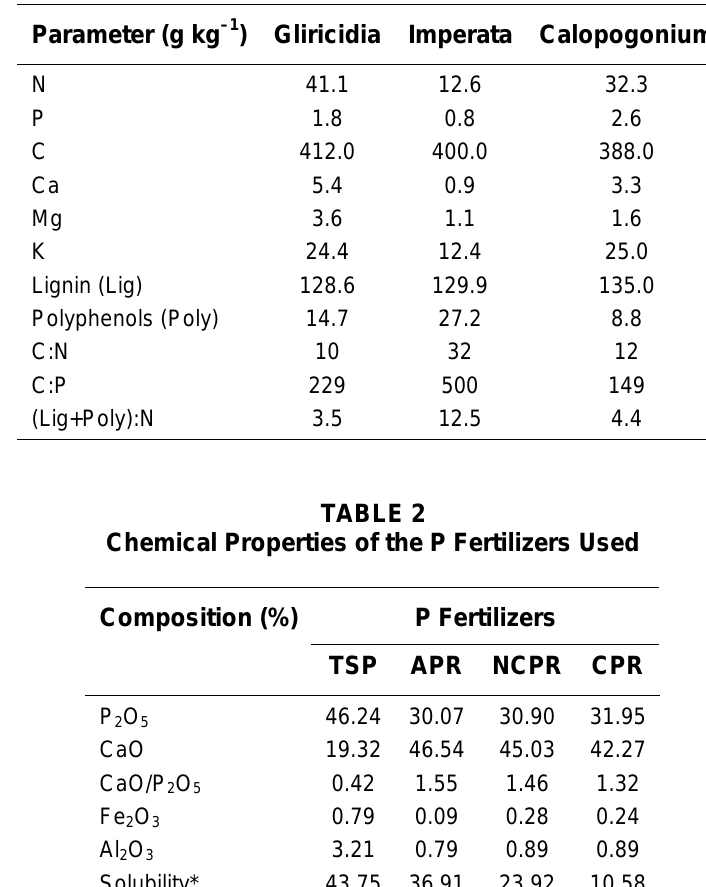
Biochemical Characteristics of the GMs Used